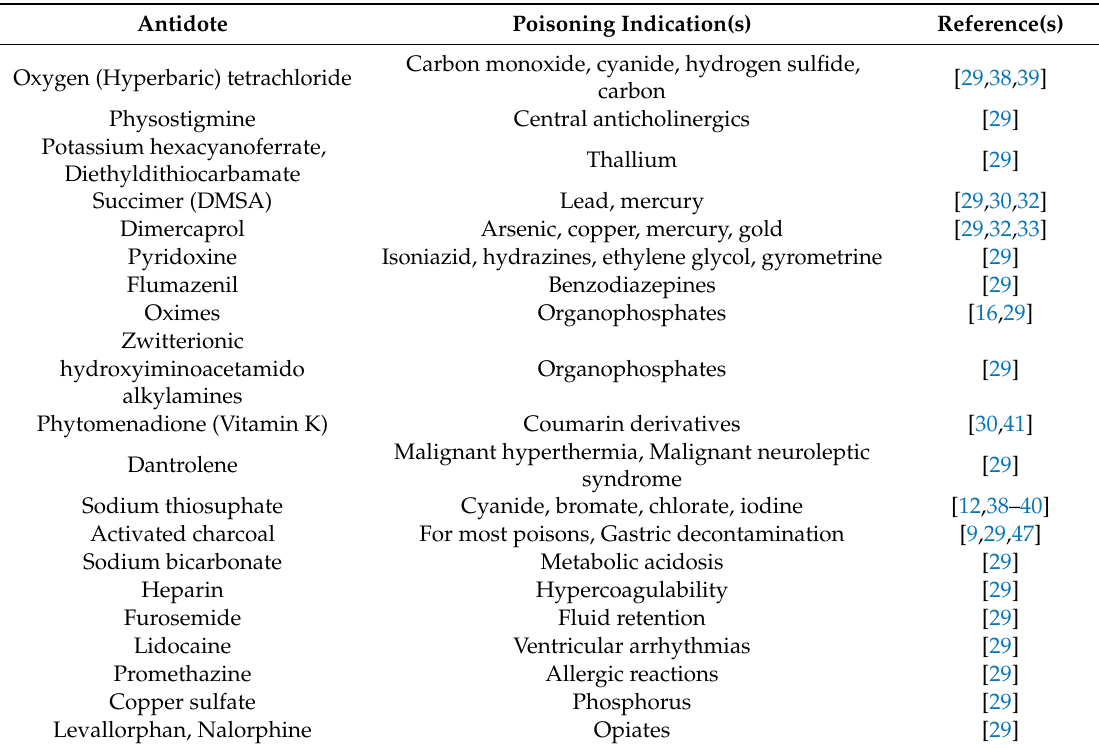
Table 1. Antidotes and their